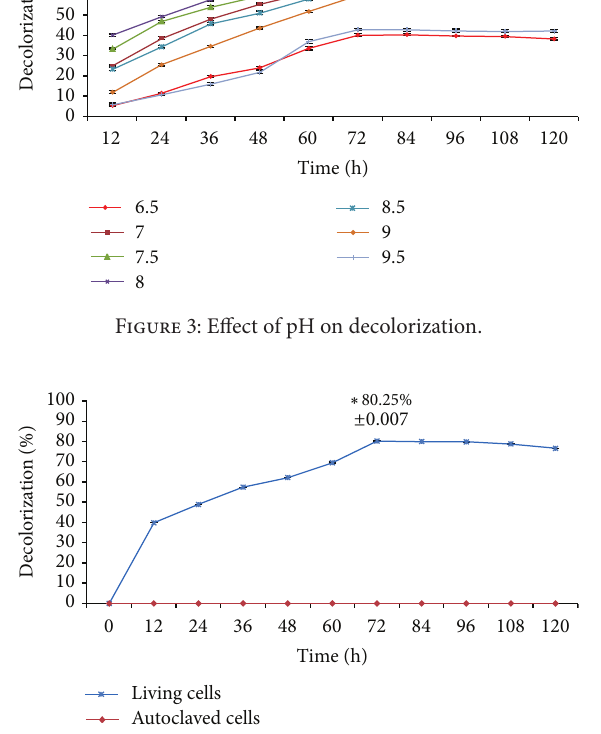
Figure 4: Effect of living and autoclaved cells on decolorization. ∗ 𝑃 < 0.05 (significant as compared to autoclaved cells).